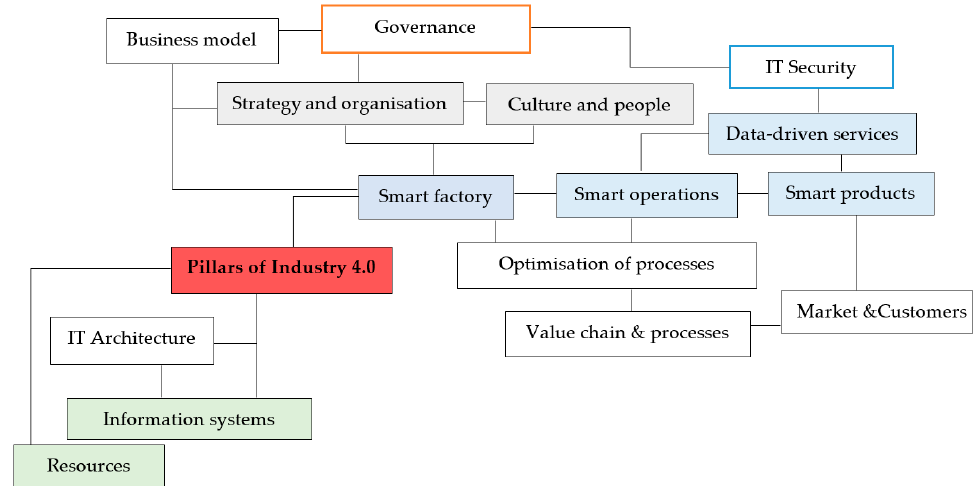
Figure 1. Key components of maturity models for Industry 4.0. Own elaboration.